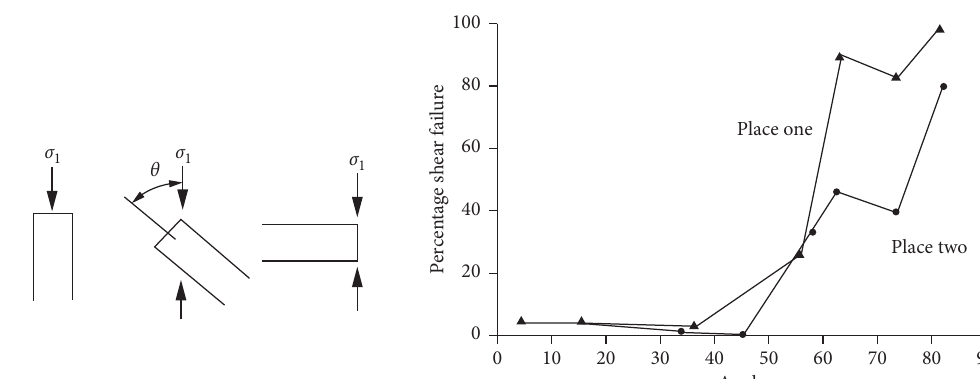
Figure 6: Roof failure at different angles relative to the maximum horizontal stress.